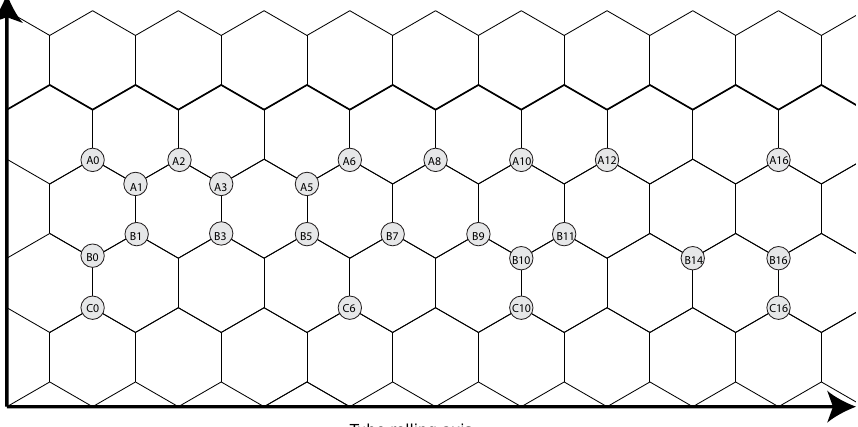
Figure 1. Naming scheme for the studied N-CNTs with two nitrogen-dopant atoms depicted on a surface that represents half of the supercell used in the calculations. The first N atom is always located at the position A0, and the other labels refer to the position of the second N atom. One zigzag chain is illustrated in